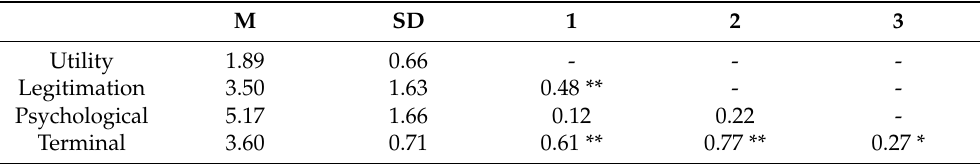
Table 4. Pearson Correlation